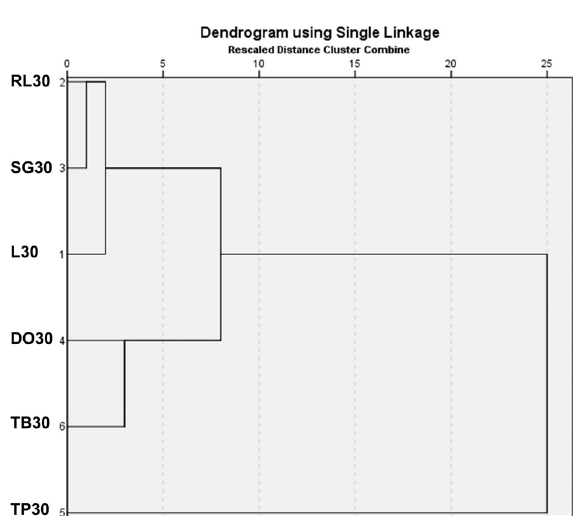
Table 3 . T he same groups w ere ob t a i ned as t he pre vi